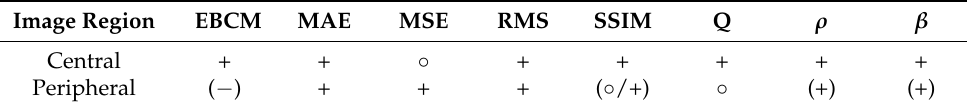
Table 4. Interpretation of quality measures values for UWFA image brightness enhancement: “+” in favor of the presented method, “ ” in favor of the reference method, “ ” if methods are comparable. − ◦ Fields within parentheses are additionally discussed in the